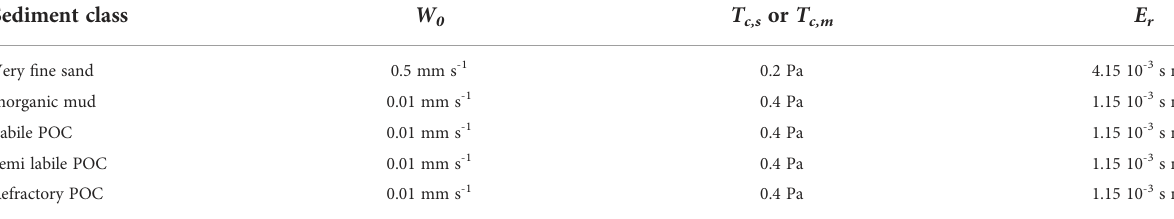
TABLE 2 Parameter setting of fi ve sediment classes in this